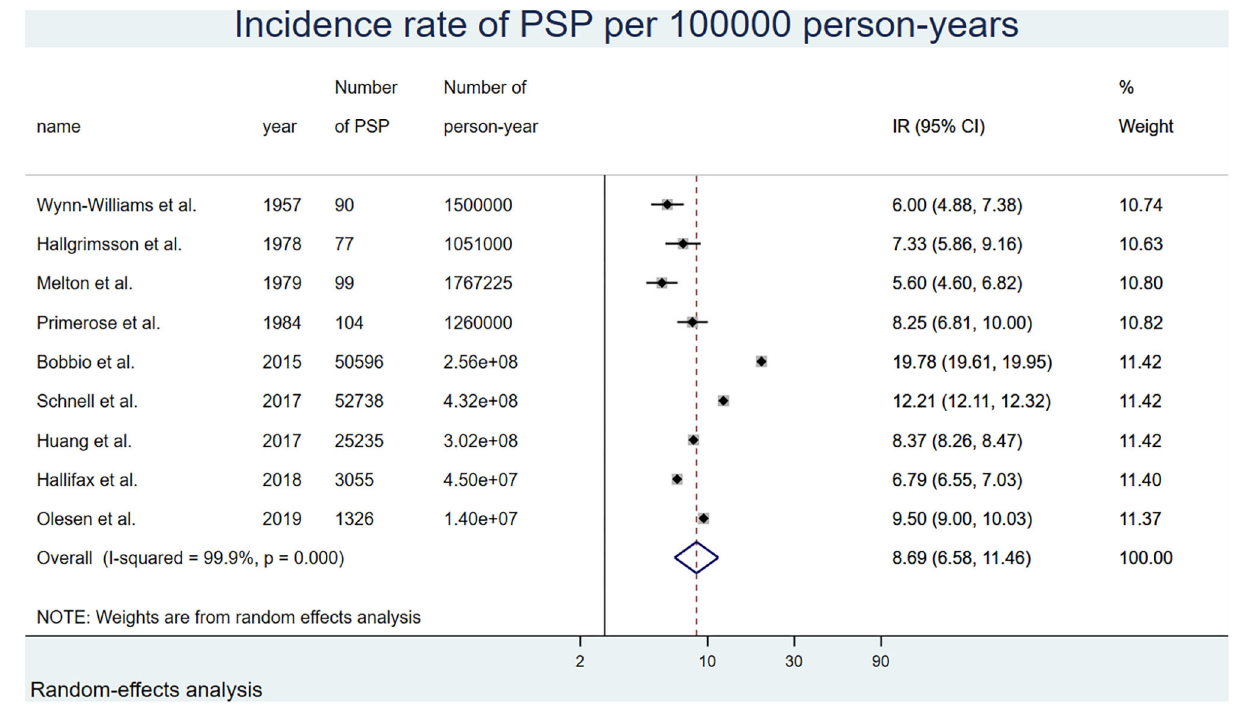
integrating studies before and after 2000, and using a median PSP duration of 16 days ( Supplementary Table S1